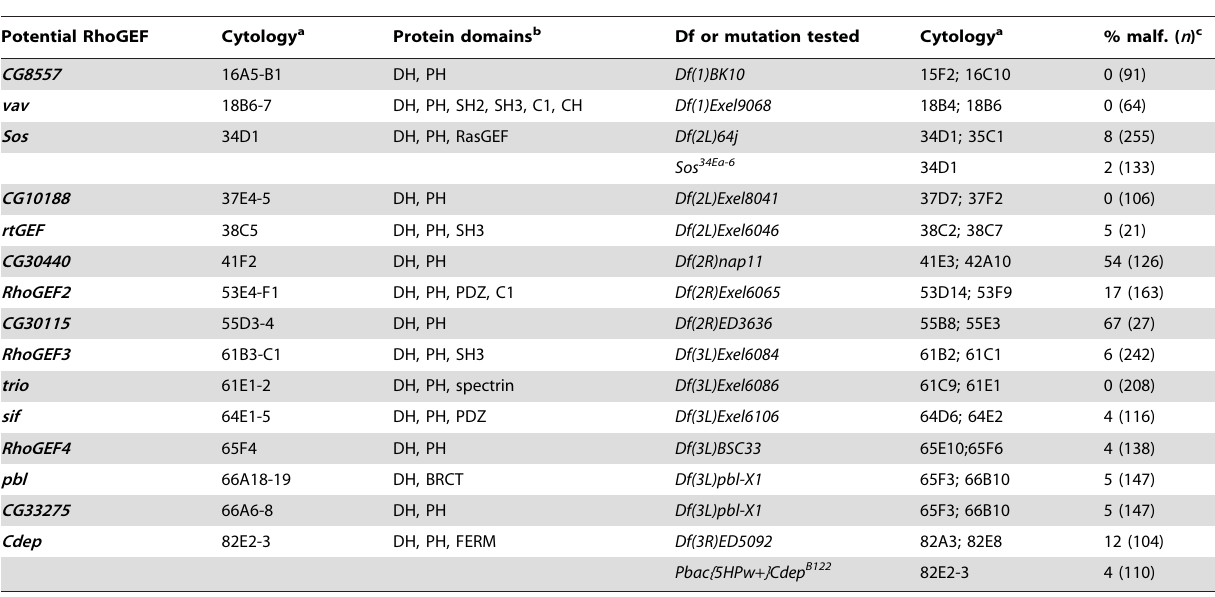
Table 4. SSNC tests to assess potential RhoGEF genes.